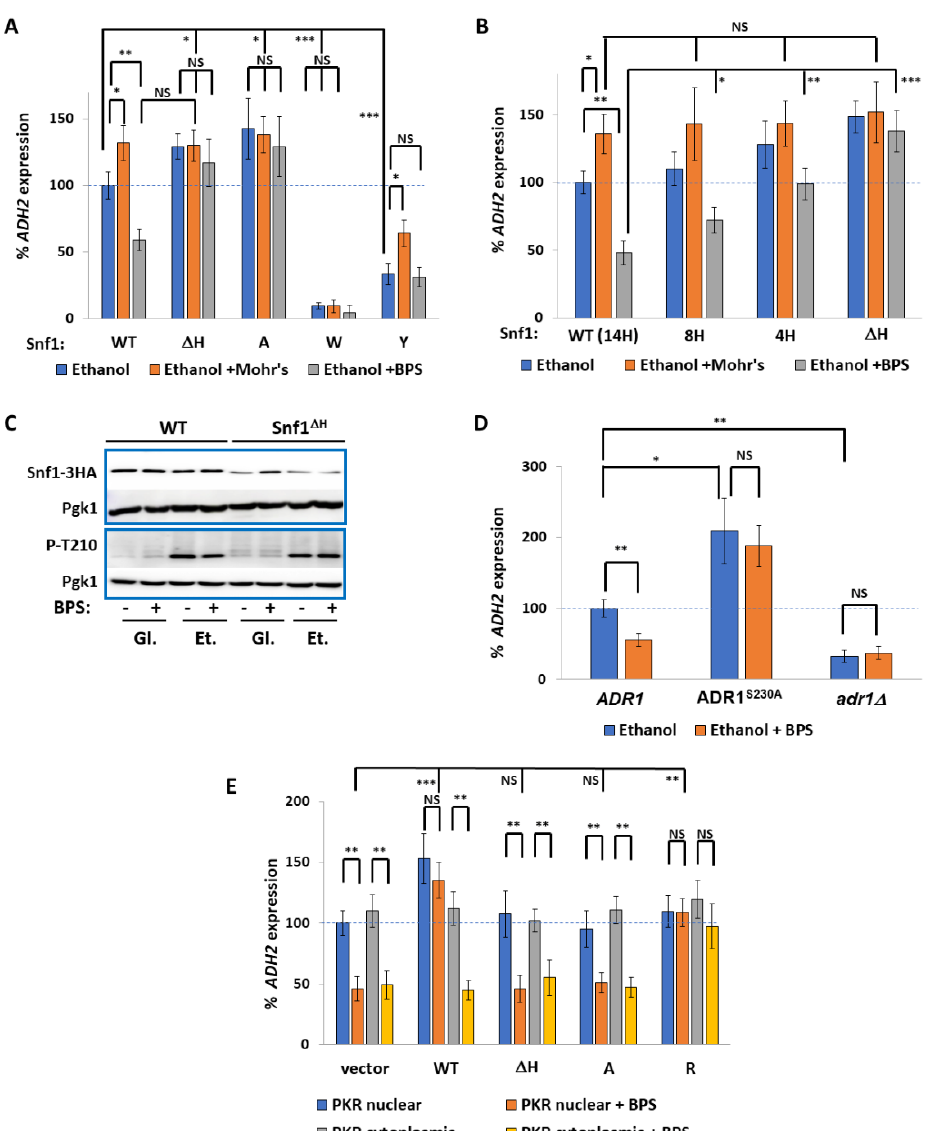
Figure 1. Snf1 is inhibited by iron chelation. ( A , B ) Rate of prADH2 ::LacZ expression in snf1 ∆ cells expressing prSNF1:: Snf1-GFP from plasmids with the indicated mutations (deletion of polyHIS ( ∆ H), substitution to poly A (A), substitution to poly W (W), substitution to poly Y (Y), four histidines (4H), eight histidines (8H)). Snf1 WT has 14 histidines in its polyHIS tract. An amount of 0.1 mM BPS or 5 mM Mohr’s salt was added as indicated. N = 3. Error bars are mean ± 1 standard deviation. t -tests were performed as indicated. NS = not significant, * = p ≤ 0.05, ** = p ≤ 0.01, *** = p ≤ 0.001. ( C ) Western blot showing phosphorylation of Snf1 under indicated conditions. Gl.: glucose; Et.: ethanol. Snf1 abundance and phosphorylation at T210 are quantified in Figure S1C and Figure S1D, respectively. ( D ) Rate of prADH2 ::LacZ expression in adr1 ∆ cells expressing ADR1 or ADR1 S230A or empty vector as indicated. An amount of 0.1 mM BPS was added as indicated. N = 3. Error bars are mean ± 1 standard deviation. t -tests were performed as indicated. NS = not significant, * = p ≤ 0.05, ** = p ≤ 0.01, *** = p ≤ 0.001. ( E ) Rate of prADH2 ::LacZ expression in WT W303a cells overexpressing the PKR of Snf1 (aa1-53) with indicated mutations ( deletion of polyHIS (ΔH), substitution to poly A (A), substitution to poly R (R)) or empty vector. The PKR was fused to the Gal Binding Domain (GBD) to send it to the nucleus, or expressed without the GBD to keep it cytoplasmic. N = 3. Error bars are mean ±1 standard deviation. t -tests were performed as indicated. NS = not significant, * = p ≤ 0.05, ** = p ≤ 0.01, *** = p ≤ 0.001.